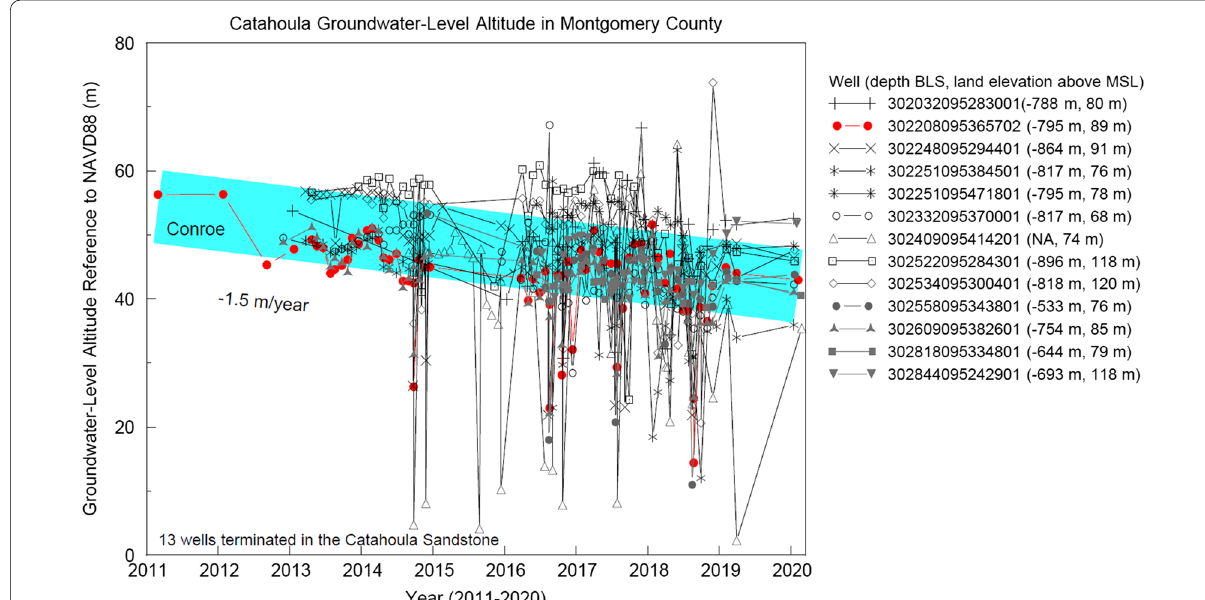
Fig. 9 Groundwater-level changes in the Catahoula sandstone in northern Montgomery County recorded at 13 wells. The locations of these wells are marked in Fig.